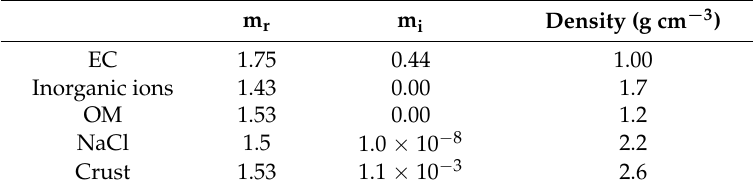
Table 1. Refractive indices and densities of externally mixed aerosols [16–18] at λ = 550